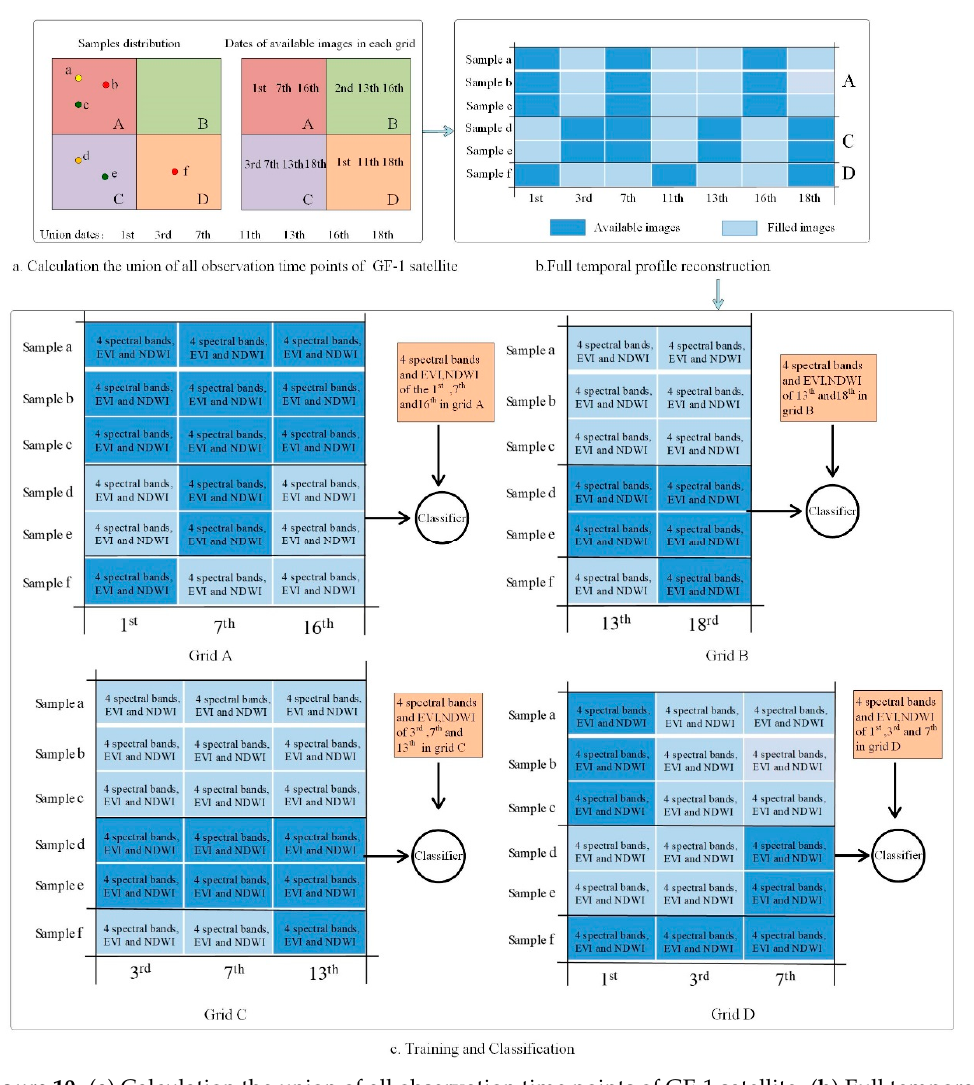
Figure 10. ( a ) Calculation the union of all observation time points of GF-1 satellite. ( b ) Full temporal profile reconstruction. ( c ) Training and classification.